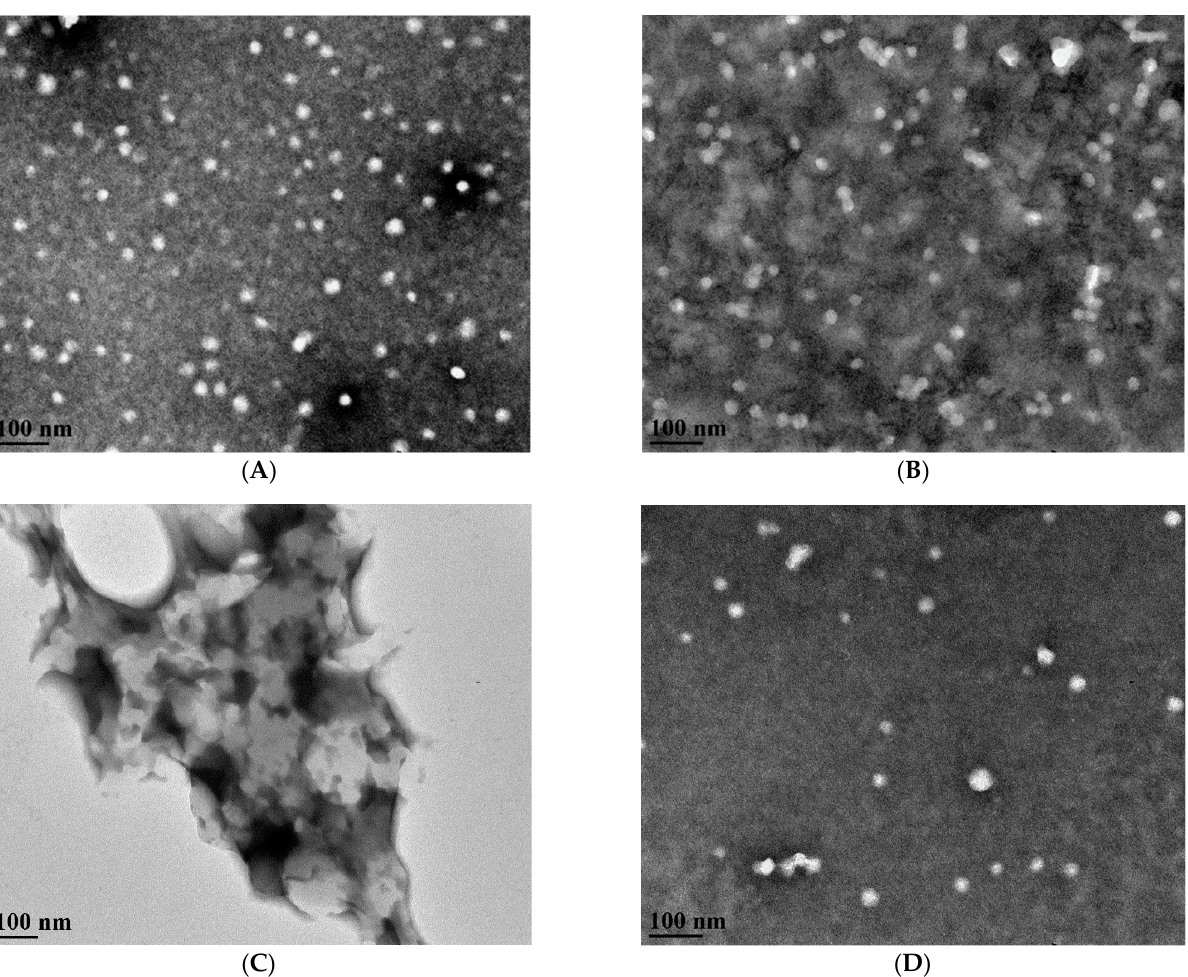
Figure 5. TEM images of ( A ) PSAMA 8 - b -PNIPAM 106 ; ( B ) PSAMA 12 - b -PNIPAM 121 ; ( C ) PSAMA 8 - b - PNIPAM 106 micelle solution heated at 50 °C; ( D ) CBZ-loaded PSAMA 8 - b -PNIPAM 106.